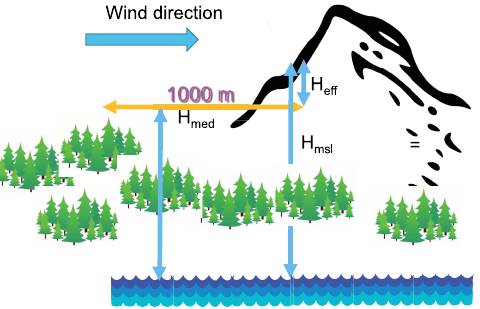
Figure 3. A visualization of the calculation of the topographic mul- tiplier M h